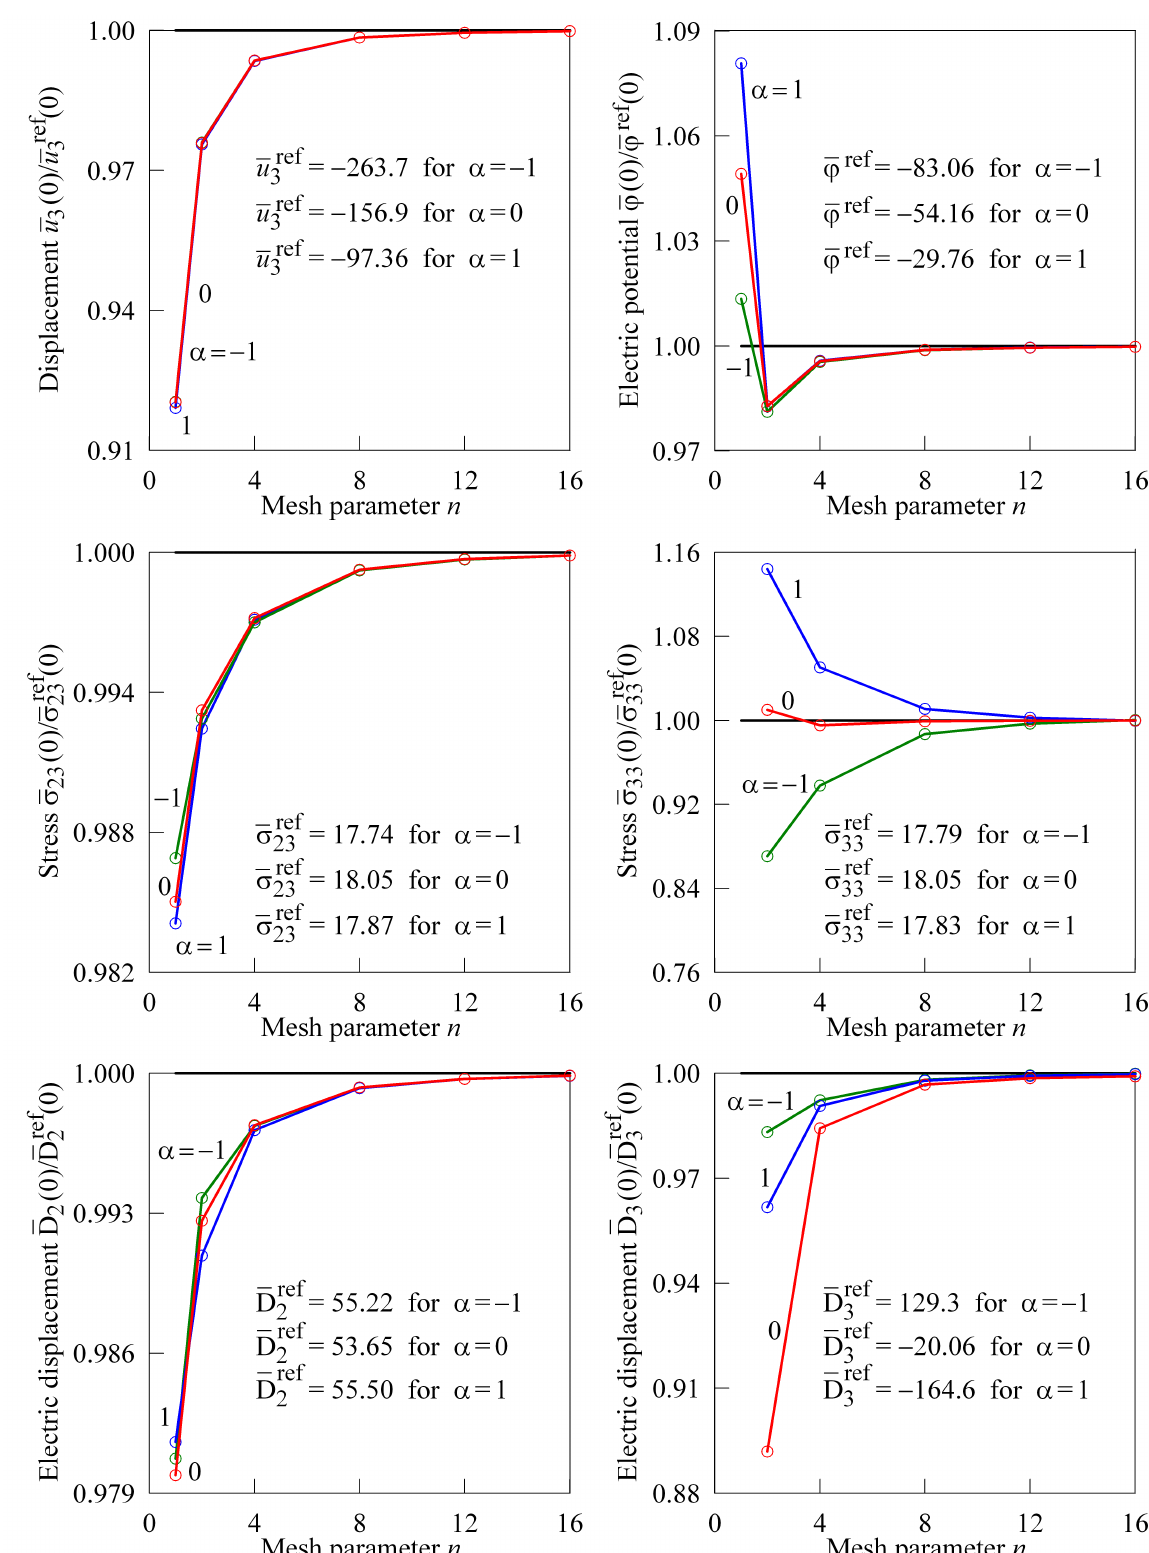
Figure 16: Convergence study due to mesh refinement for a thin cylindrical shell using five SaS and regular 2 n × 8 n meshes with n = 1, 2, 4, 8, 12 and 16; reference solution is provided by a regular 64 × 128